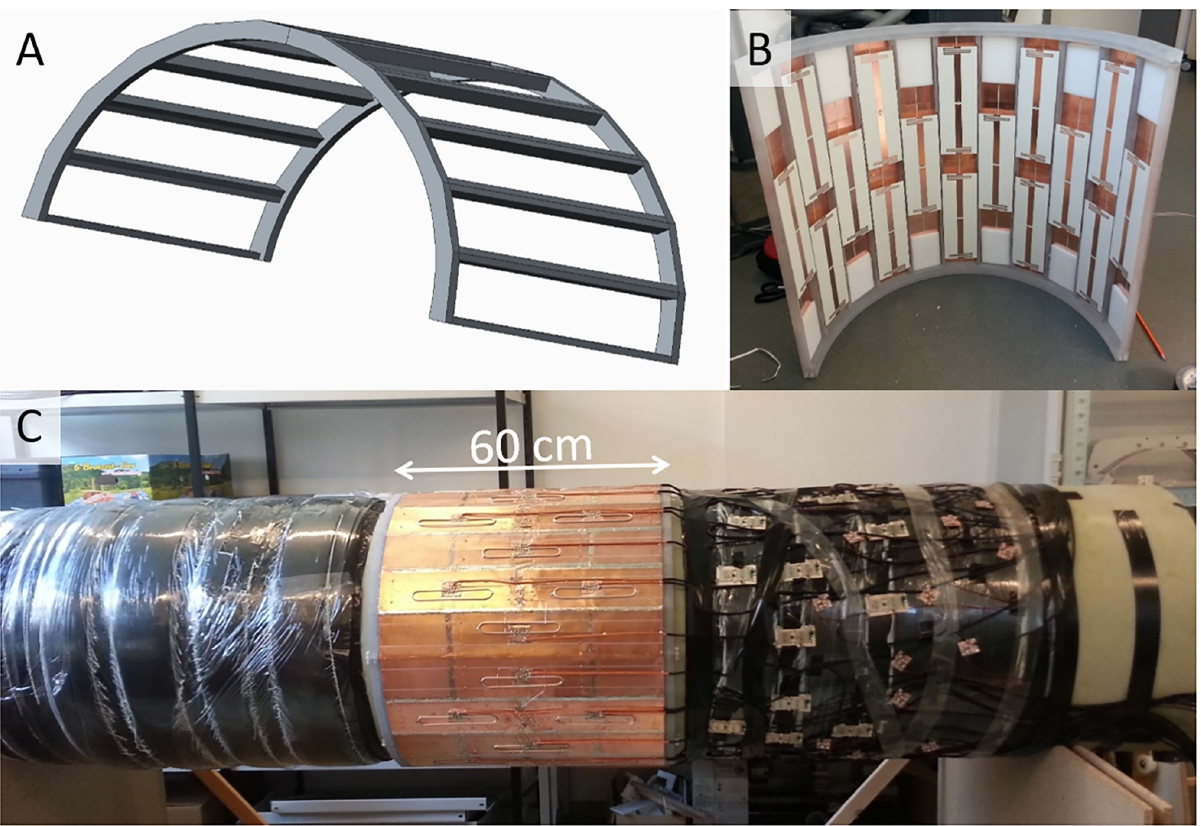
Fig 5. 32-channel body coil. A) shows the polycarbonate frame that defines the mechanical structure. B) shows an inside view of one half of the array. 16 micro strip-line elements with meanders are visible. C) shows the two halves of the array mounted on the bore liner, with the T/R switches on the bore liner to the right side of the image (service